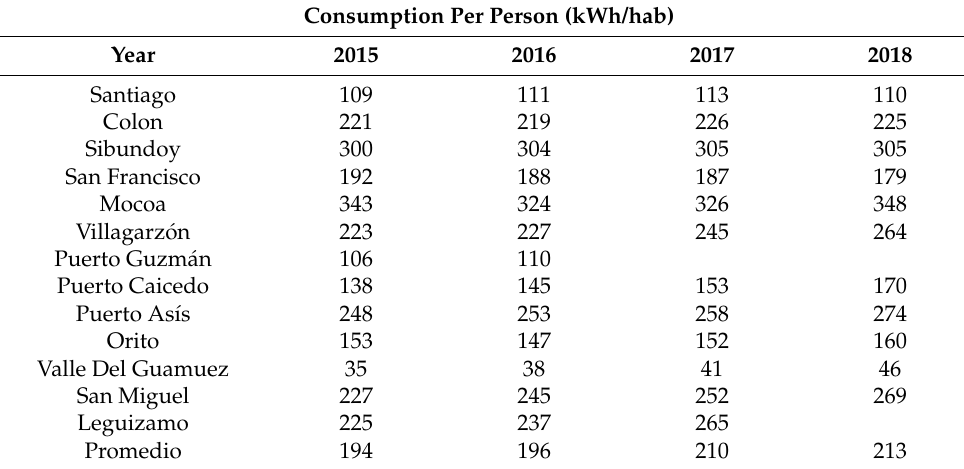
Table 10. Residential electric energy consumption per inhabitant in